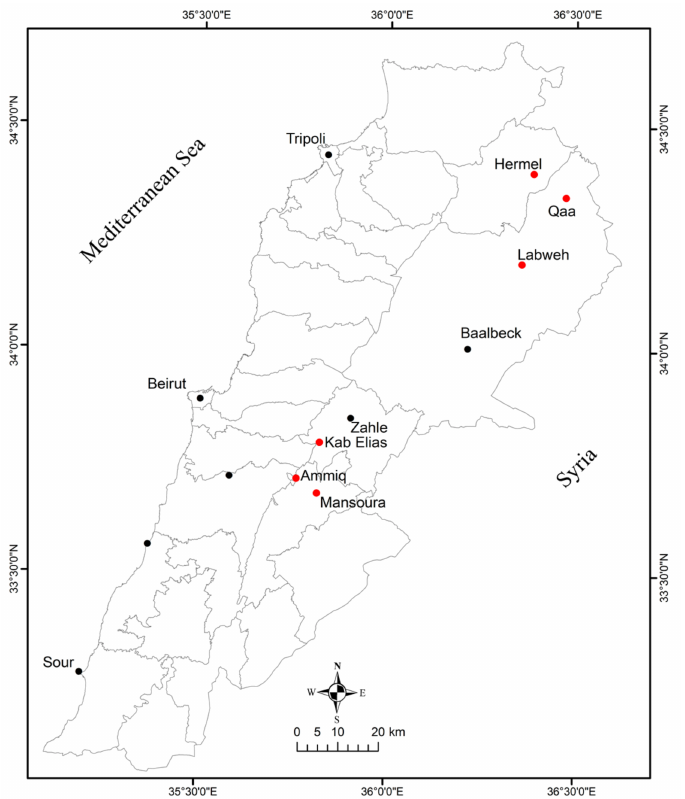
Figure 1. Schematic map of Lebanon showing the geographic origin (red spots) of the 170 collected eggplant leaf samples from Bekaa